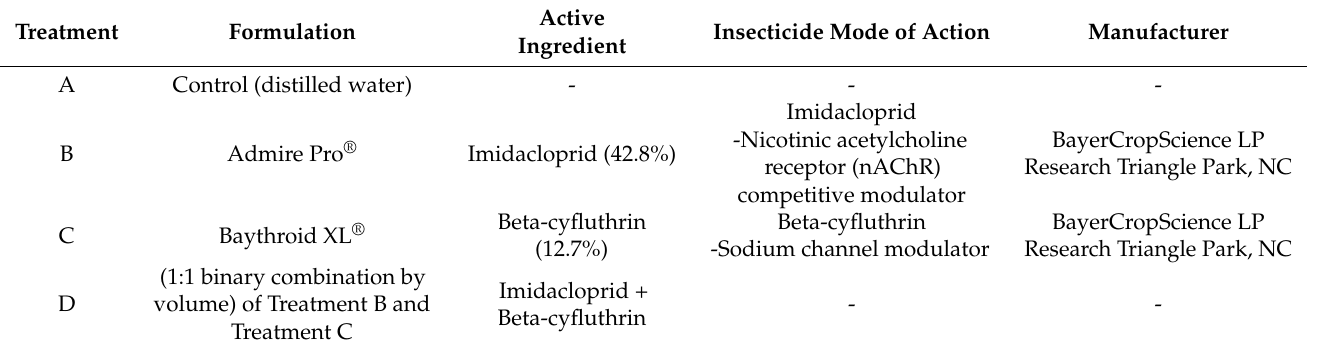
Table 3. Active ingredients and modes of action of individual active ingredient insecticide assessed for acute whole-body contact toxicity to adult male and female Osmia lignaria (Experiment 3).